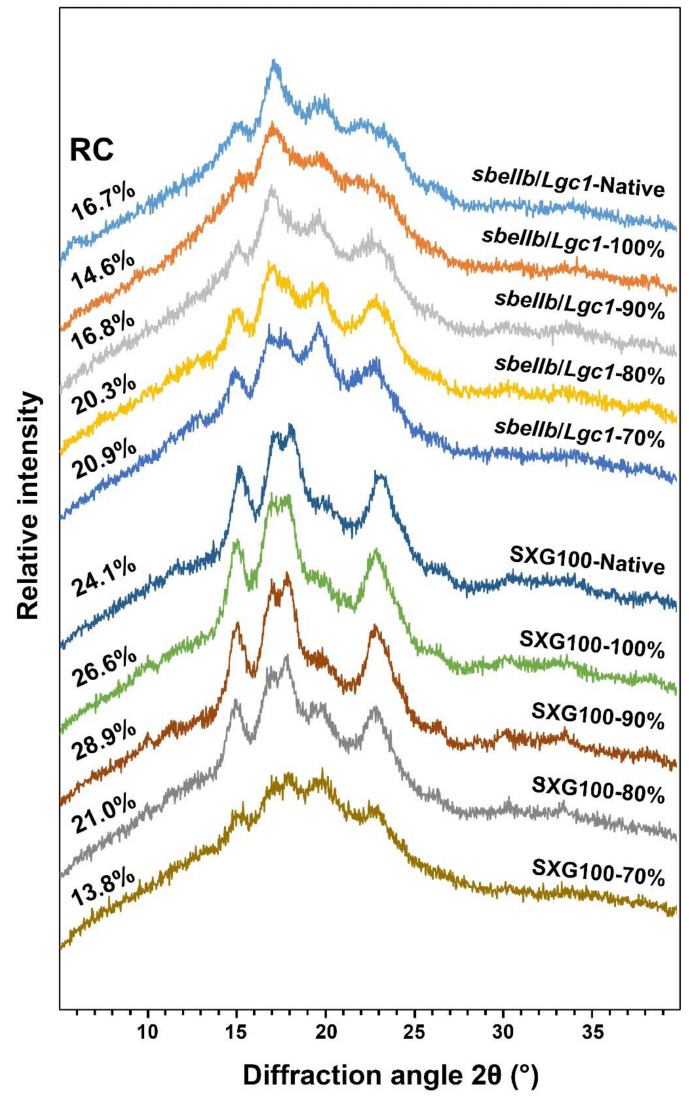
Figure 4. X-ray diffraction patterns of the native and HMT rice flours of sbeIIb / Lgc1 and SXG100. The percentages of the left part of the penal indicate the relative crystallinity (RC). Table 3. Gelatinization properties of native and HMT rice flours of sbeIIb / Lgc1 and